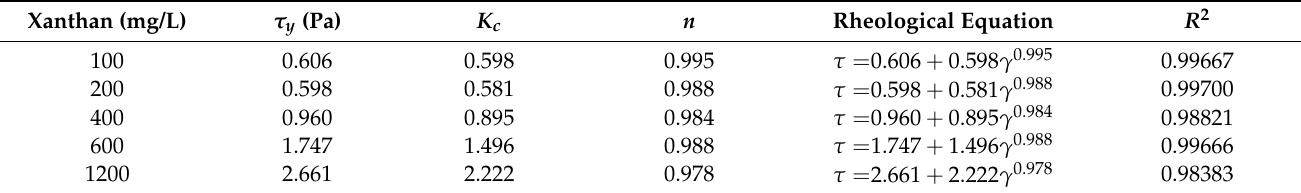
Table 2. Rheological equation of xanthan gum solution with different concentrations.